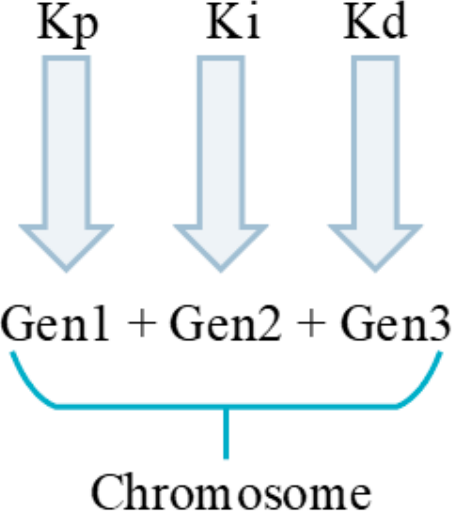
Figure 3. Chromosome structure created for a PID controller.